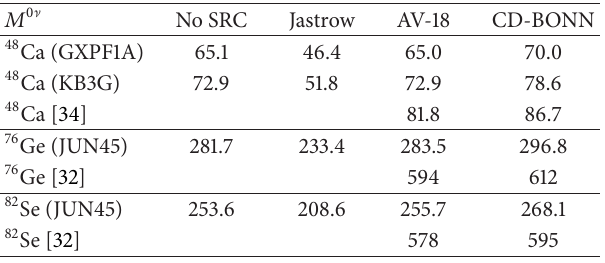
Table 1: 0 ] 𝛽𝛽 NMEs values for heavy neutrino mechanism and comparison to other results in the literature.